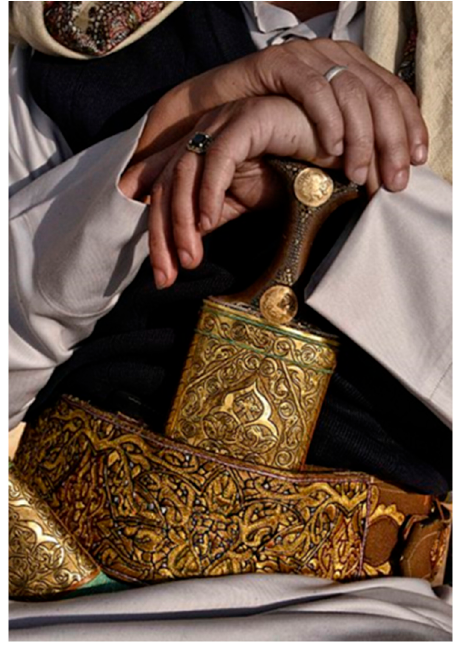
Figure 1. Jambiyya : Traditional Yemeni (Waddington 2014).